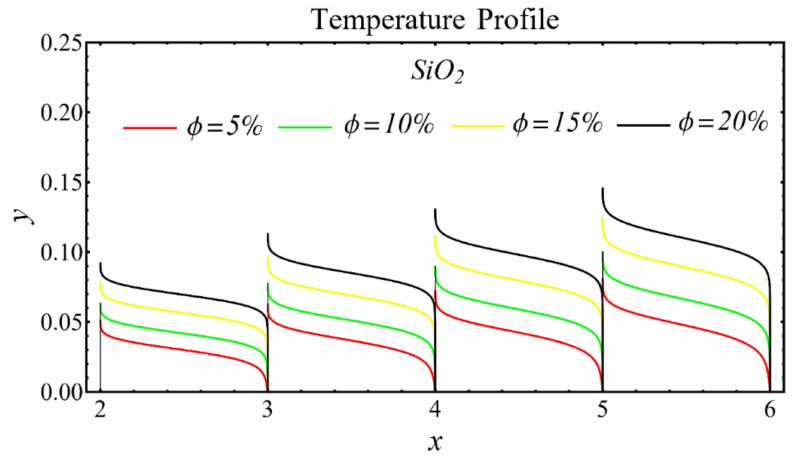
Figure 13. Temperature profile of SiO 2 -EG nanofluid under influence of nanoparticle concentration.